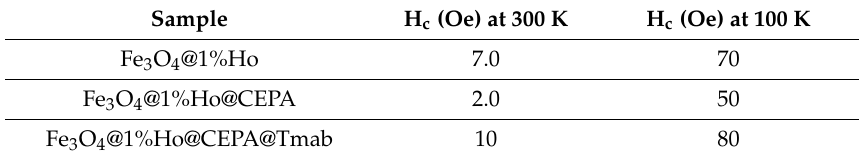
Figure 5. Magnetization isotherms for ( a ) Fe 3 O 4 @1%Ho, ( b ) Fe 3 O 4 @1%Ho@CEPA, ( c ) Fe 3 O 4 @1%Ho@CEPA@Tmab. All curves are normalized for the mass of NPs core. ( d ) The temperature dependence of ZFC and FC magnetization at 100 Oe for Fe 3 O 4 @1%Ho ( d ) . Table 2. Values of coercivity for NPs before and after modifications with organic compounds